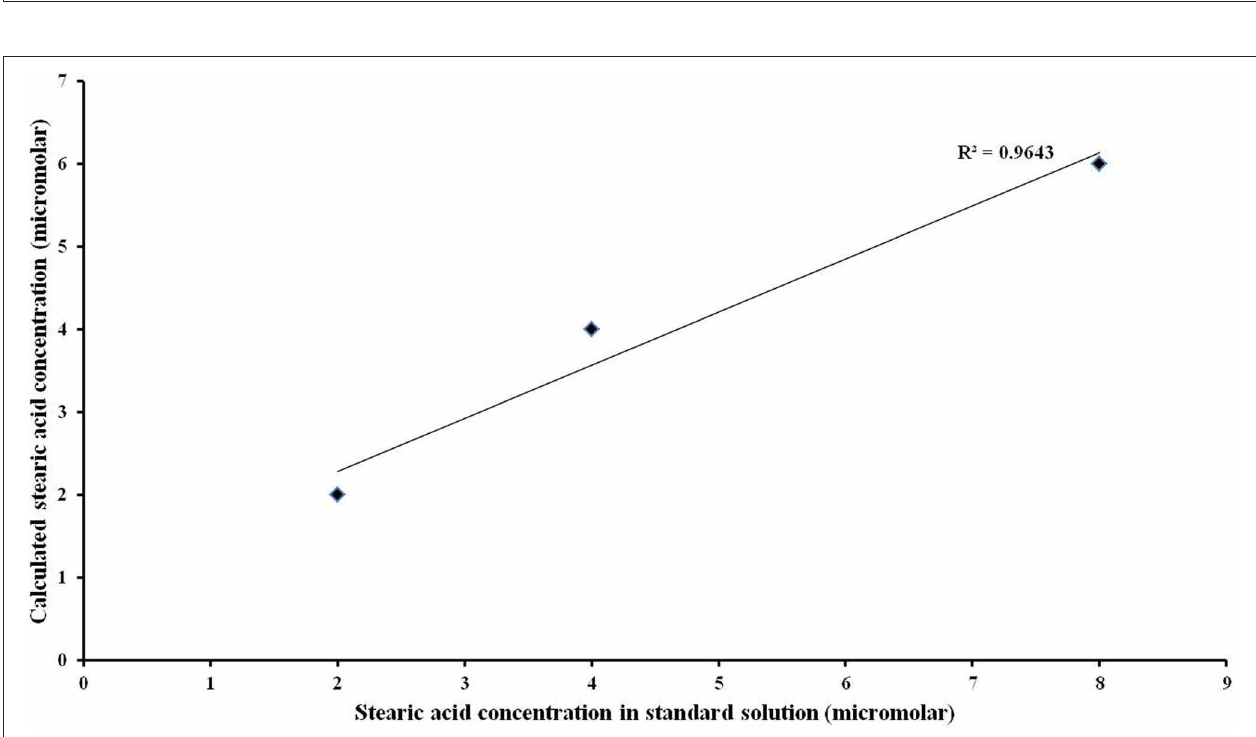
Esterified palmitic acid that was present in other lipid classes tri, di, and monoacylgycerols, phospholipids, and cholesterol esters was not derivatized.